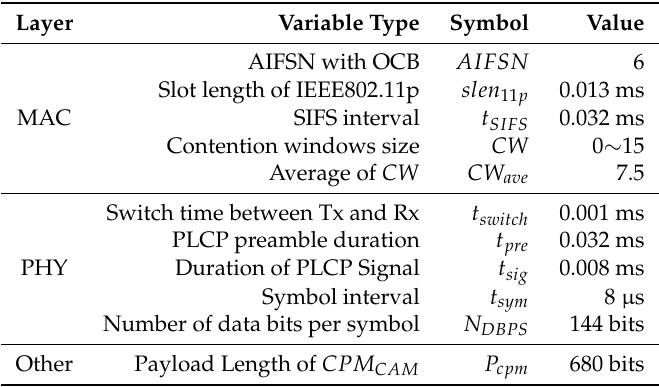
Table 1. MAC and Physical Layers’